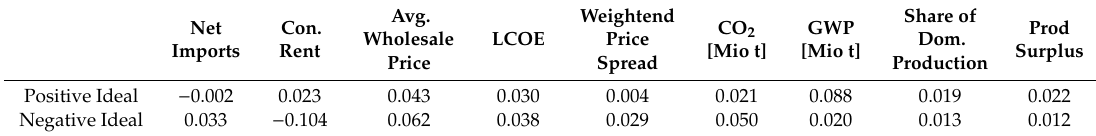
Table A2. Positive-ideal and negative-ideal alternatives. Source: Own compilation.